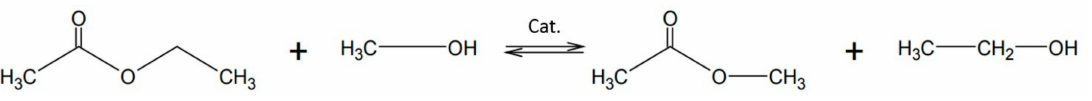
Figure 3. Ethyl acetate methanolysis as a model transesterification reaction.